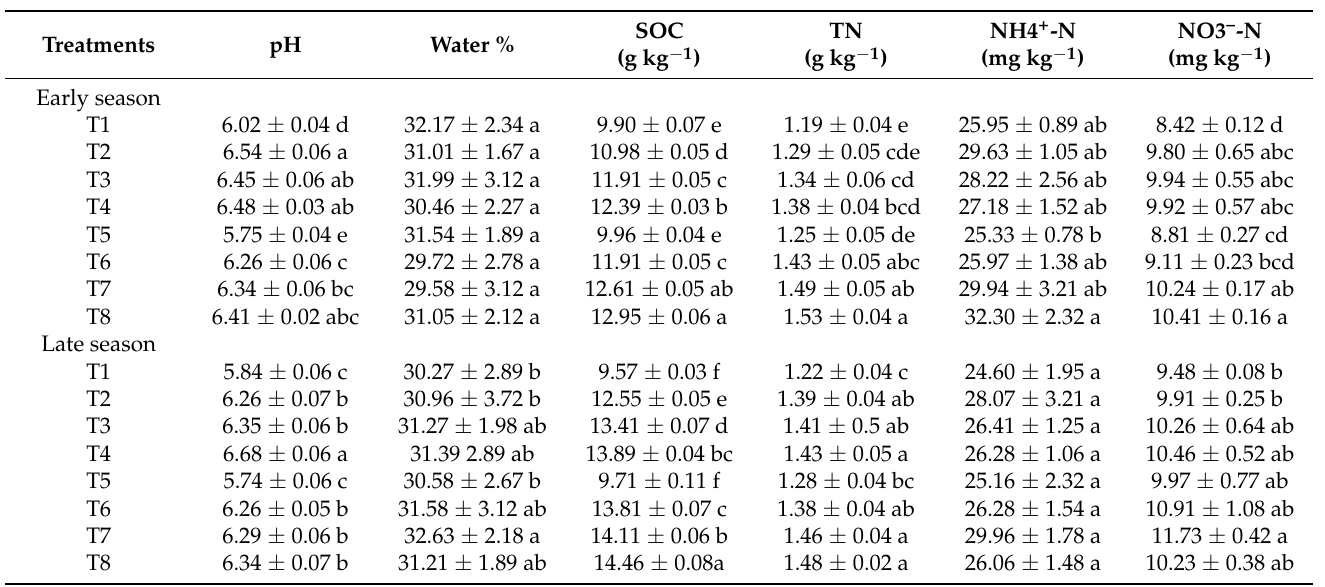
Table 2. Responses of soil chemical properties to low- and high-dose N application with and without biochar